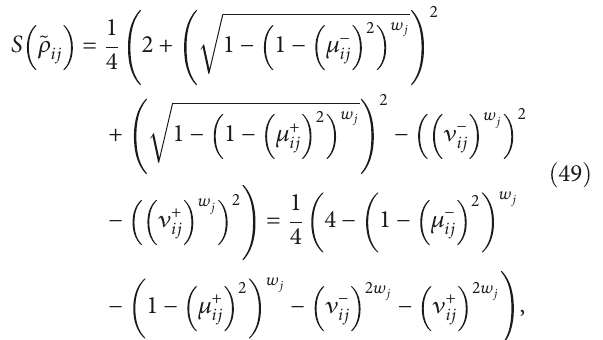
Table 2: Separations and closeness coe ffi cients yielded by the IVPF TOPSIS method. Anchored judgments with z displaced ideals i D ∗ D # CC d i i